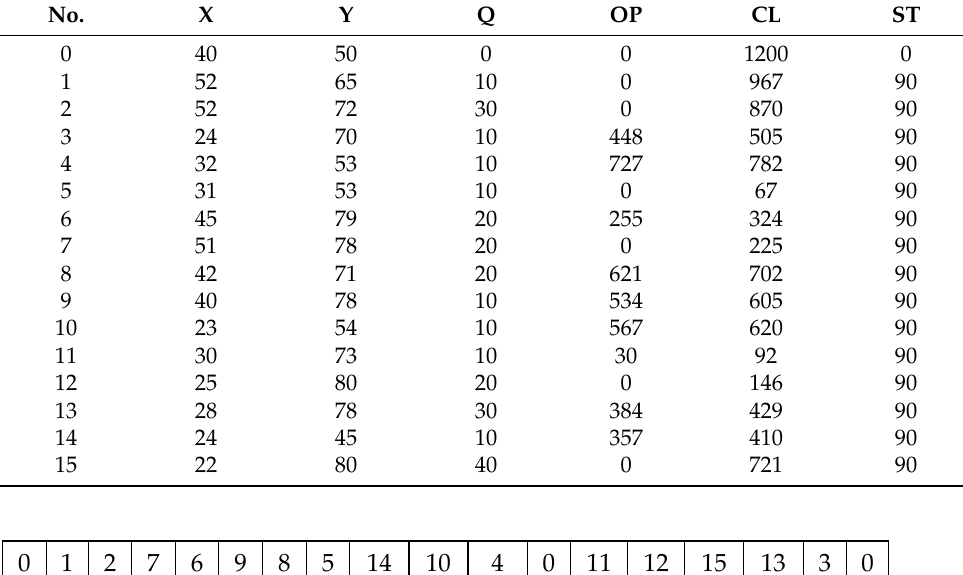
Table 1. PCPTW instances with 15 customers.